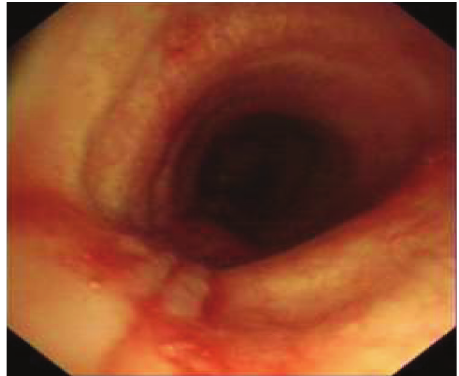
Figure 4: Bronchoscopic view, tracheal wall after excision of the lesion with